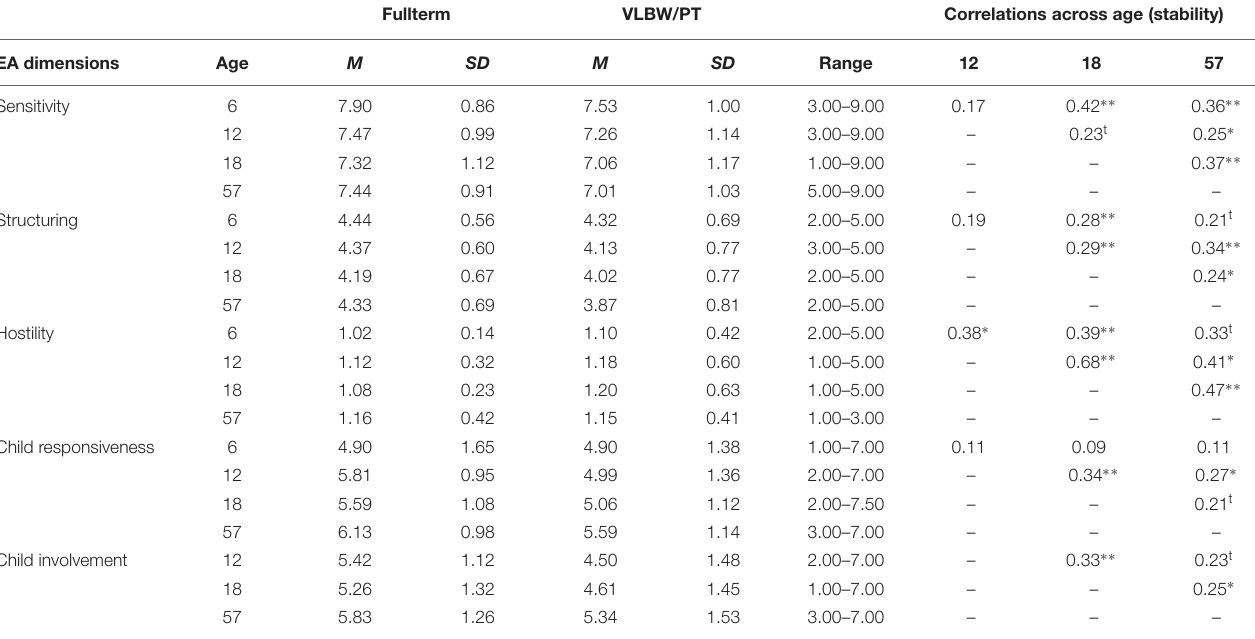
TABLE 2 | Descriptive statistics and correlations across child age (relative stability) for the Emotional Availability (EA) Scales. Fullterm VLBW/PT Correlations across age